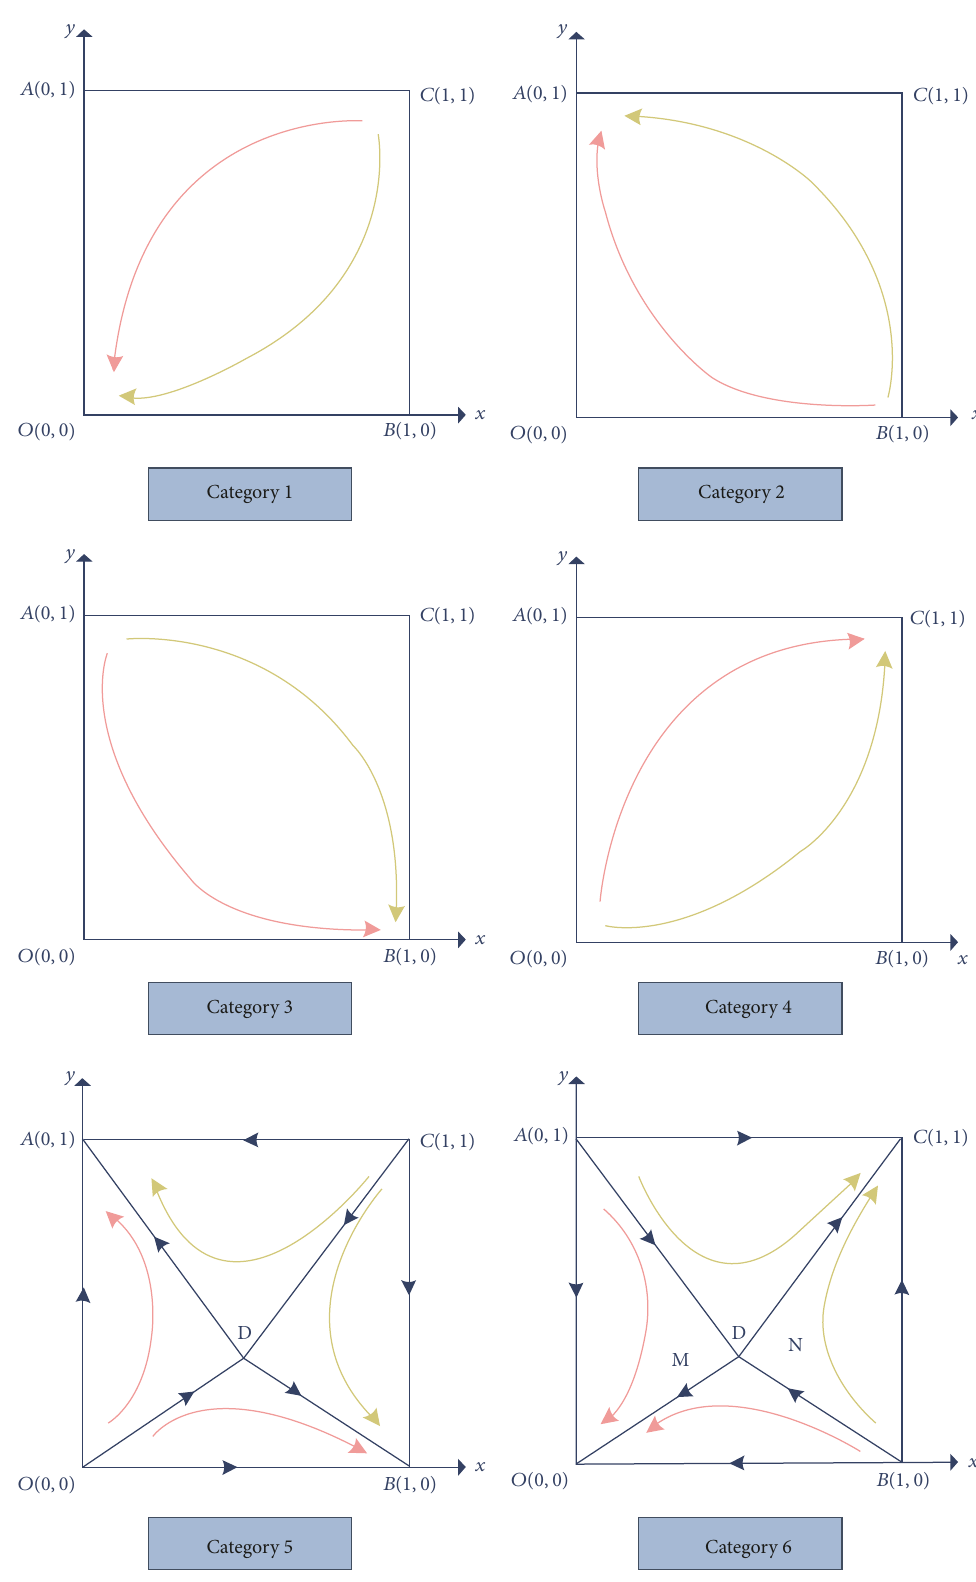
Figure 1: Diagrams on the dynamic evolution of the equilibrium